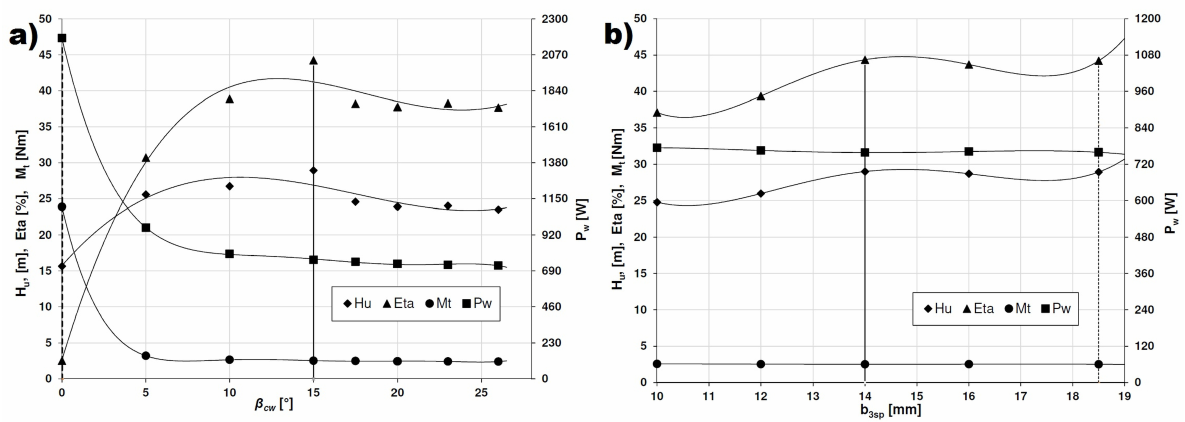
Figure 17: Impact of changes of the angle B cw location of a volute tongue (a) and the width b 3 sp (b) of the spiral casing Table 4: Influence of changes of the shape of the cross-sectional profile in a volute casing.